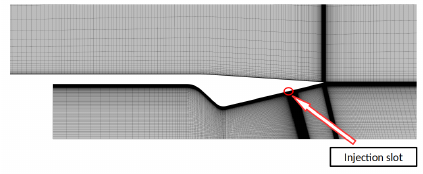
Figure 10. Mesh detail close to the injection